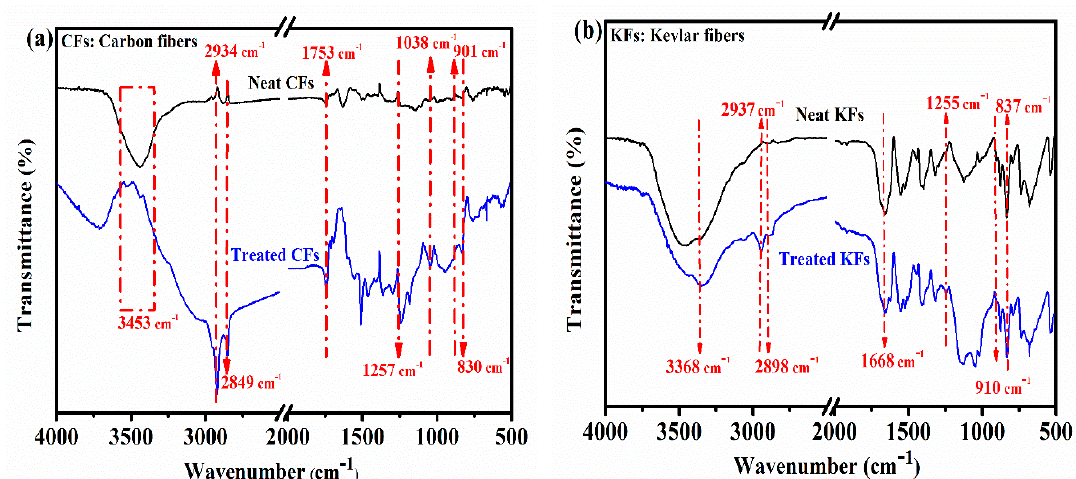
Figure 2. FTIR spectra of the treated and untreated carbon fibers ( a ) and Kevlar fibers ( b ).